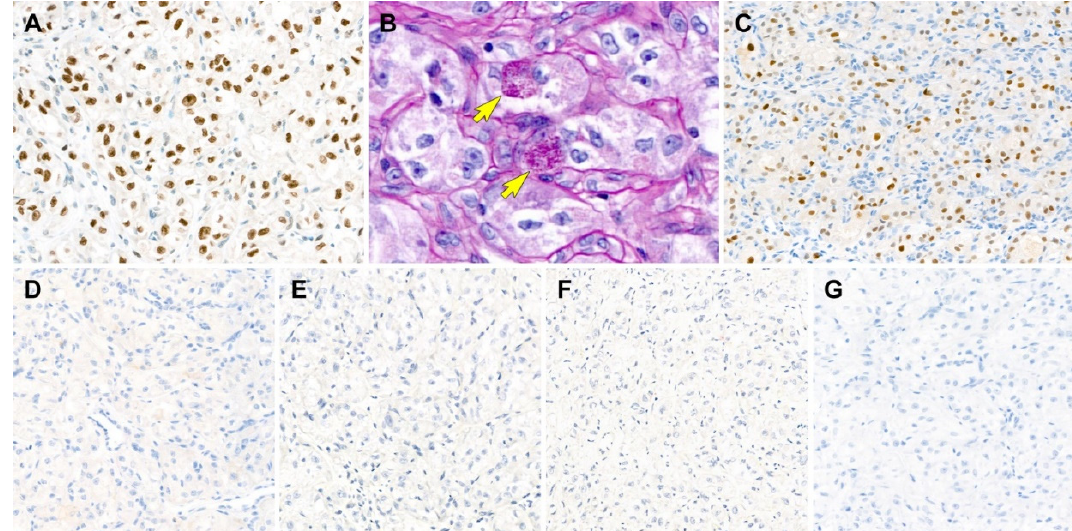
Figure 6. Results of immunostaining and special staining (case 2). ( A ) The tumor cells are diffusely positive for transcription factor E3 with moderate-to-strong staining intensity. ( B ) Periodic acid- Schiff with diastase digestion staining reveals eosinophilic granular materials within the cytoplasm (yellow arrows). ( C ) Similar to case 1, progesterone receptor is strongly positive for tumor cell nuclei. ( D – G ) The tumor cells are negative for ( D ) CD10, ( E ) human melanoma black 45, ( F ) melan-A, and ( G ) pan-cytokeratin. Original magnification: A, 400×; B, 600×; C–G, 200×.